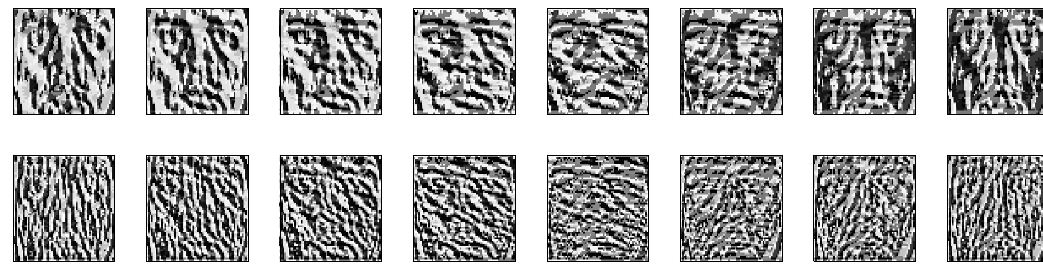
Figure 6. Examples of the LBP map images obtained by applying the LBP operator to the multiple Gaussian derivative filter images shown in Figure 5.